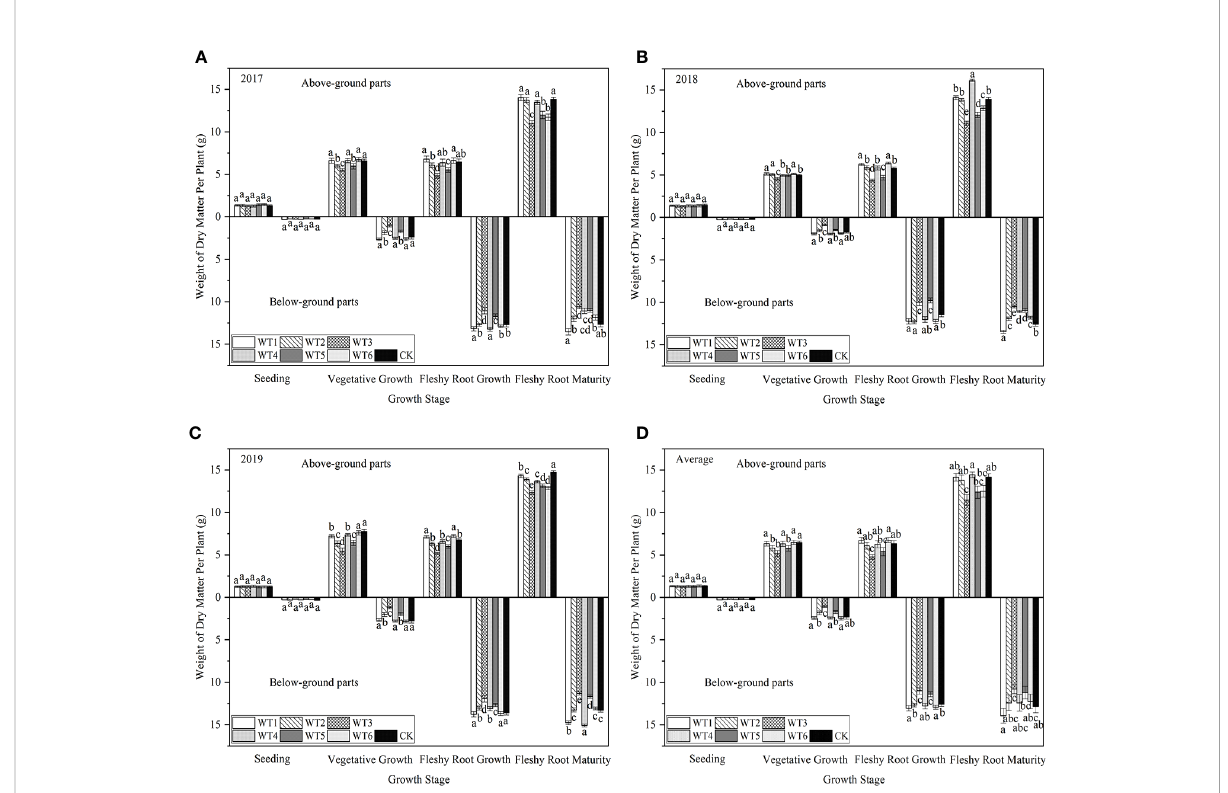
FIGURE 9 Dry matter accumulation in I. indigotica plants in different water de fi cit treatments. (A – D) describe the dry matter accumulation in 2017, 2018, 2019, and the average of these three years, respectively. Different lowercase letters in the same column indicate signi fi cant differences ( P < 0.05). Data were presented as mean ± SE (n =